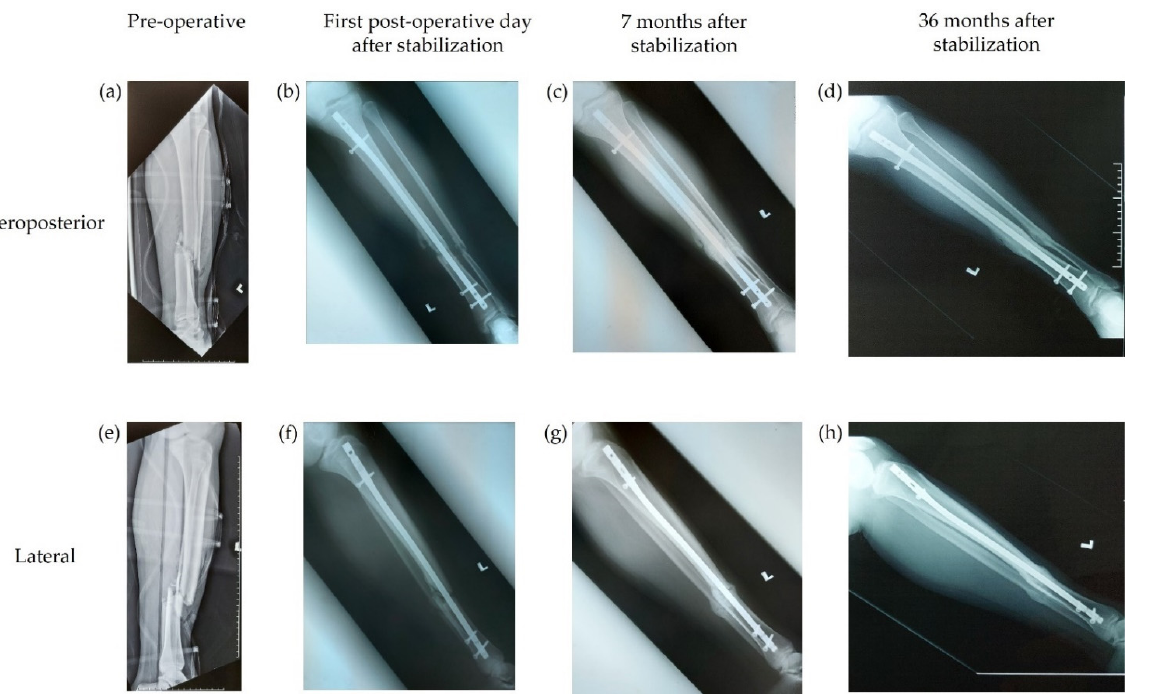
Figure 2. Example of delayed bony union, as assessed by the independent experts. Radiographs from an 18-year-old male patient with a Gustilo type IIIa open femoral fracture. ( a – d ) Anteroposte- rior radiographs. ( e – h ) Lateral radiographs. ( a , e ) Radiographs taken pre-operatively; ( b , f )